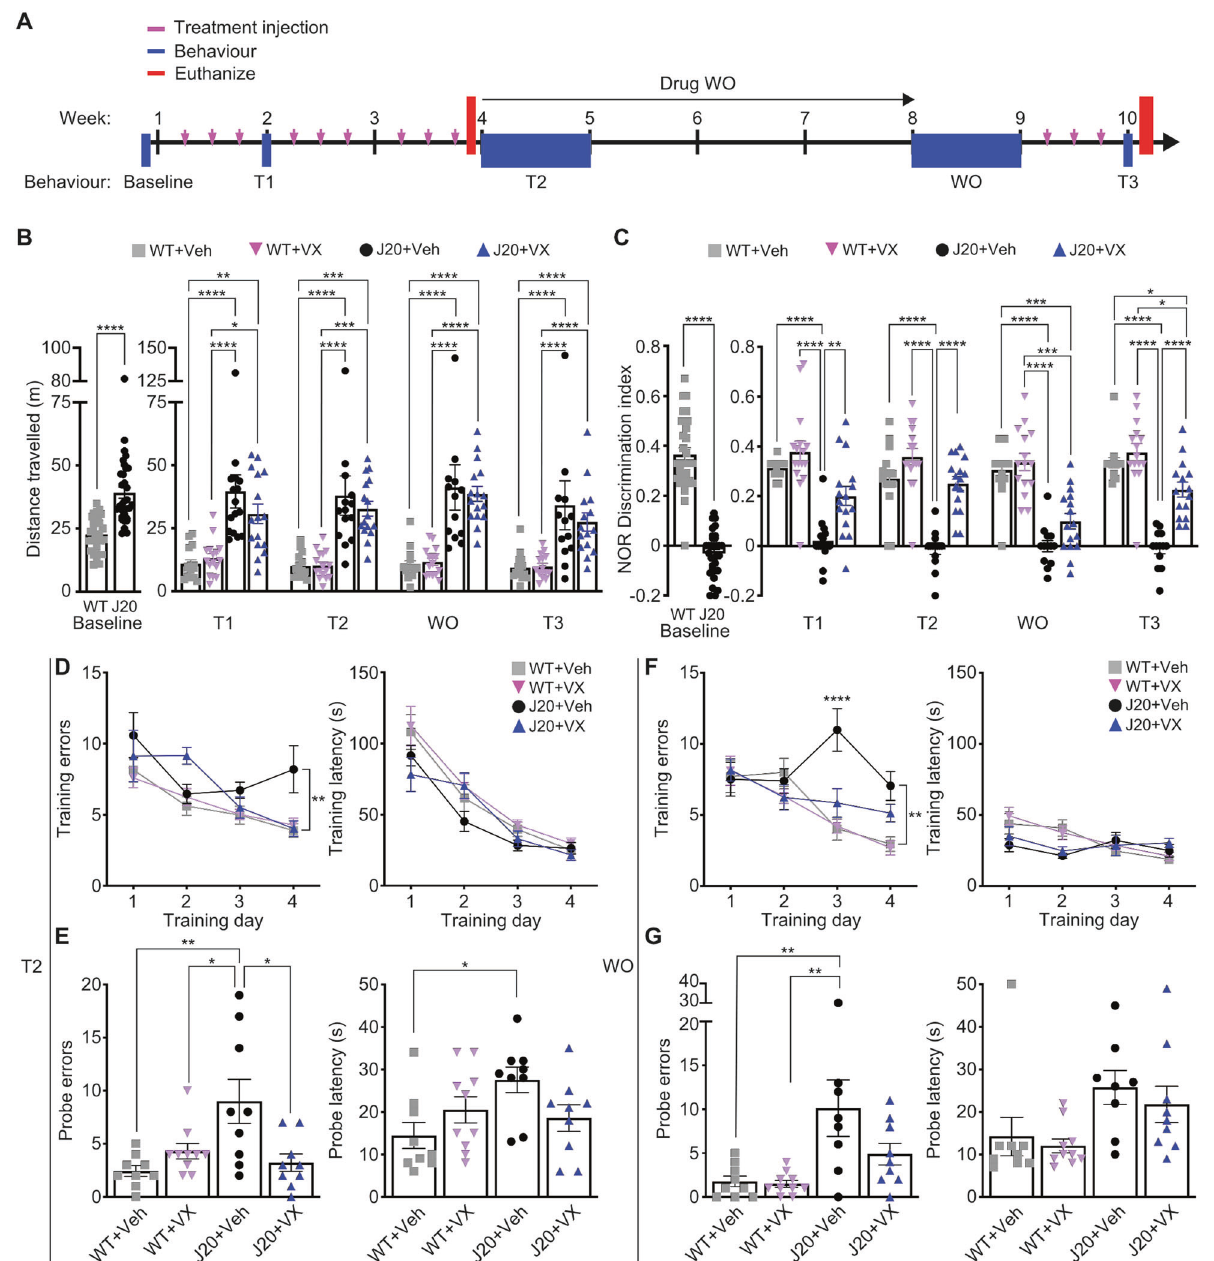
Fig. 1 VX-765 reverses cognitive de fi cits in 15-month-old J20 mice. A Experimental treatment and behavioural paradigm illustrating treatment injections (pink), behavioural time points (blue), and euthanasia for post-mortem analyses (red). B Distance travelled in open fi eld task at baseline [ n = 31 WT, n = 32 J20; t = 6.44, p < 0.0001, unpaired t -test] and in vehicle (Veh) or VX-765 (VX)-treated mice at T1 (3 injections), T2 (9 total injections), WO (1 month washout), and T3 (12 total injections) [ n = 15 WT + Veh, 16 WT + VX, 16 J20 + Veh, and 16 J20 + VX; F time-point = 6.83, p = 0.0002; F treatment = 13.28, s < 0.0001, two-way ANOVA, Bonferroni ’ s post-hoc]. C Novel object recognition (NOR) discrimination index at baseline [ t = 13.22, p < 0.0001, unpaired t-test] and at T1, T2, WO, and T3 [F treatment = 95.18, p < 0.0001, two-way ANOVA, Bonferroni ’ s post-hoc]. Number of mice per group are indicated in ( B ). D – G Barnes maze behaviour of n = 9 WT + Veh, 10 WT + VX, 9 J20 + Veh, and 9 J20 + VX at T2 ( D,E ) and n = 9 WT + Veh, 10 WT + VX, 8 J20 + Veh, and 9 J20 + VX after 1-month WO ( F , G ). D , F Barnes maze learning acquisition showing primary errors (left) and primary latency (right) to reach the target during the 4-day training period at ( D ) T2 [Training errors: F training-day = 15.41, p < 0.0001; F treatment = 4.67, p = 0.007, two-way repeated-measures ANOVA, Bonferroni ’ s post-hoc compared to WT + Veh] and ( F ) WO [Training errors: F training-day = 12.81, p < 0.0001; F treatment = 5.63, p = 0.003; F interaction = 4.25, p = 0.0001; = 1.73, p = 0.02, two-way repeated measures ANOVA, Bonferroni ’ s post-hoc compared to WT + Veh]. E , G Barnes maze probe showing F subject primary errors (left) and primary latency (right) to blocked target at ( E ) T2 [errors: F genotype = 5.391, p = 0.03; F interaction = 10.47, p = 0.003; latency: F interaction = 6.00, p = 0.02, two-way ANOVA, Bonferroni ’ s post-hoc] and ( G ) WO [errors: F genotype = 13.43, p = 0.0009; latency: = 8.28, p = 0.007, two-way ANOVA, Bonferroni ’ s post-hoc]. Bars represent mean ± SEM; symbols denote performances of individual F genotype mice. * p < 0.05, **p < 0.01, *** p < 0.001, **** p < 0.0001.